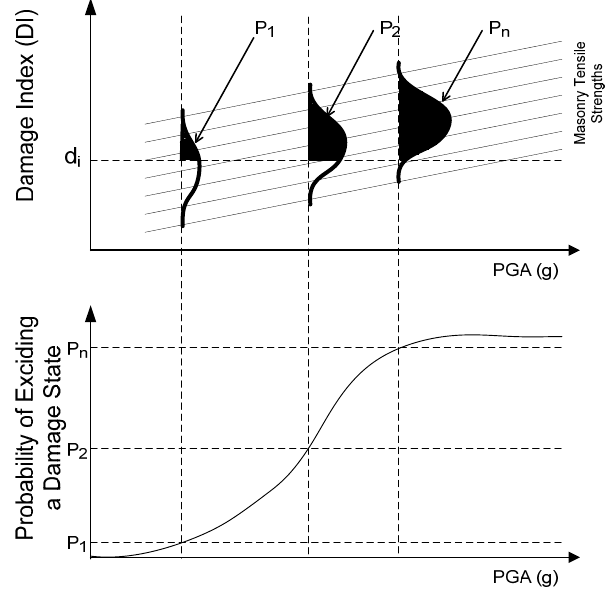
Figure 4. Development process of analytical fragility curves.